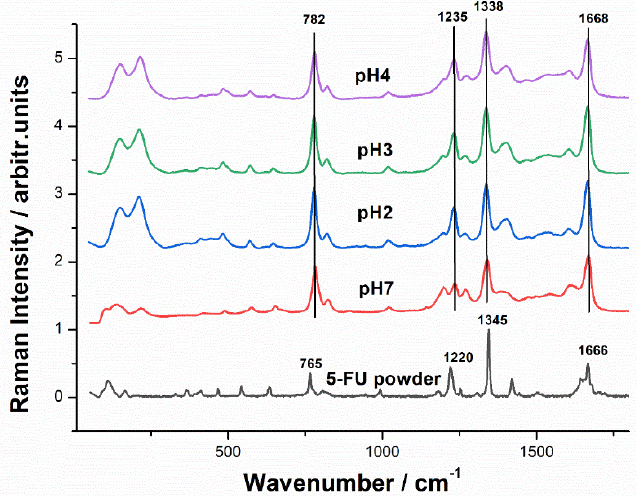
Figure 2. Micro-Raman spectrum of 5-FU powder (lower) compared to the SERS signal of the 5-FU solution (0.02 µ g/mL) on AgNPs at various pH values: pH 7 (ultrapure water), pH 4, pH 3, and pH 2. Raman and SERS spectra were acquired using 1 s exposure time, 1 acquisition, 220 mW laser power, and a 20× magnification microscope objective. Excitation: 532 nm.